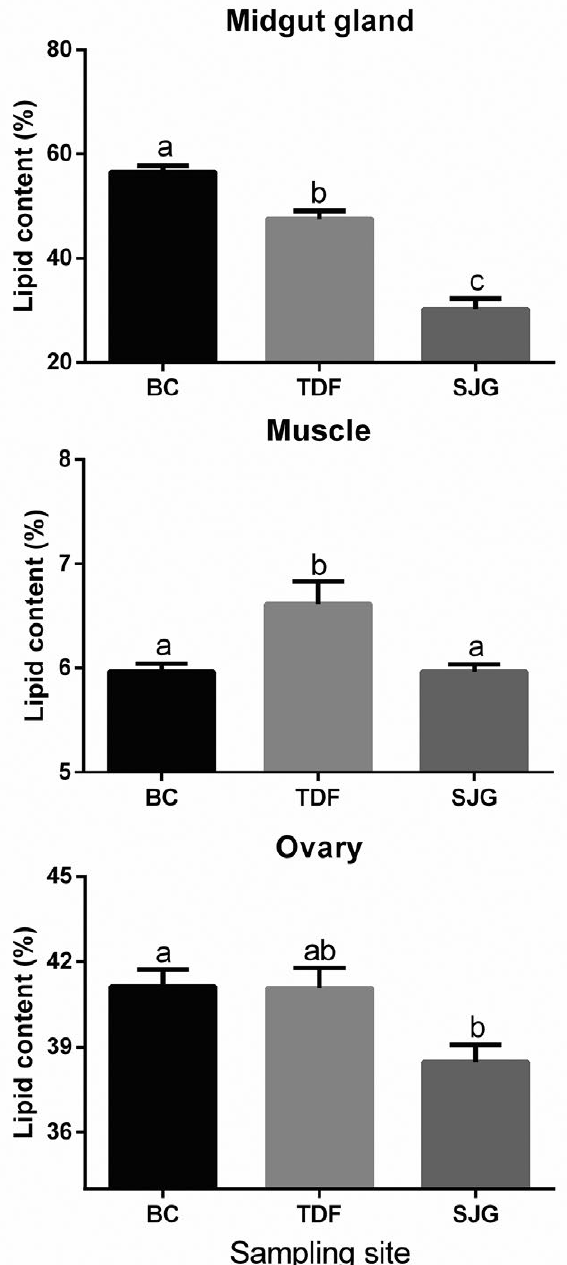
Fig. 4. – Lipid content (mean±SE) in midgut gland, muscle and ovary of L. santolla from the three sampling sites: Beagle Channel (BC), Tierra del Fuego (TDF) and San Jorge Gulf (SJG). Different letters indicate significant differences between sites (ANOVA and Tukey, p<0.05; or Kruskal Wallis and Dunn,